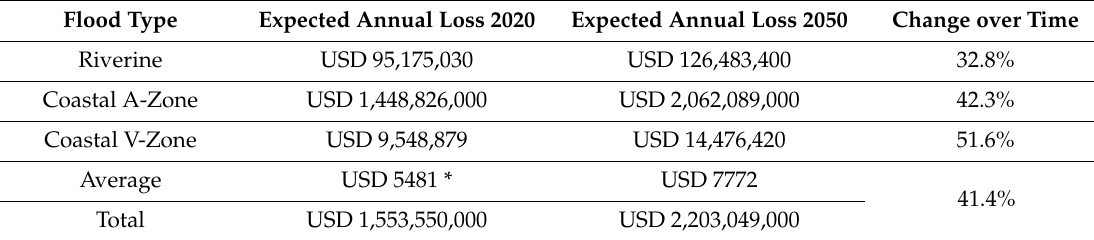
Table 2. Total expected loss in 2020 and 2050 by different flood types.